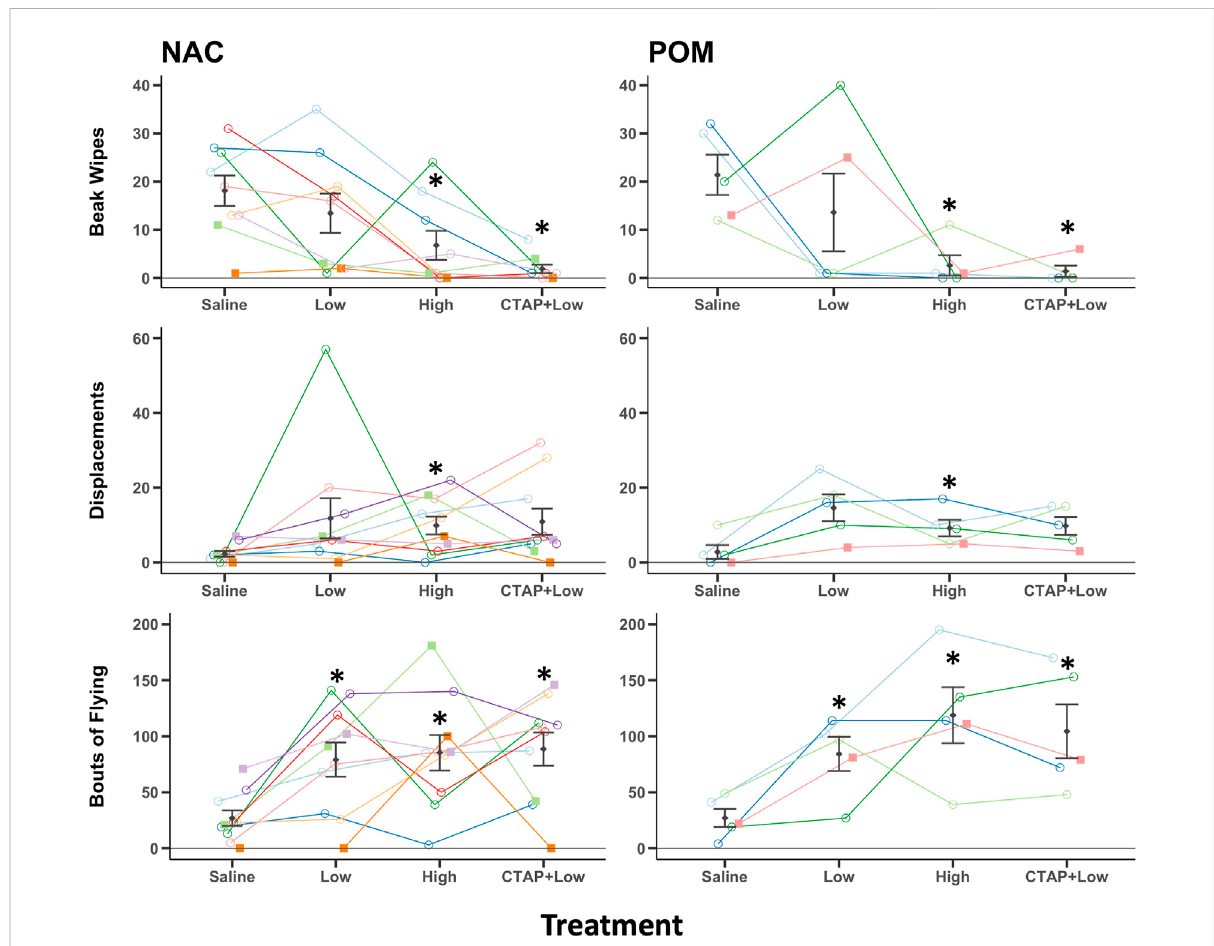
FIGURE 4 MOR stimulation in NAC or POM suppresses beak wiping but facilitates displacements and locomotion. Effects of intra NAC and intra POM treatments ofSaline, low doseDAMGO(2.5 μ g; Low),high doseDAMGO (25 μ g; High) and theMORantagonist CTAP followed bylow dose DAMGO (CTAP + Low) on beak wiping, displacements, and fl ights. Mean ± sem is indicated for each group. Individual repeated data points are shown for males (circles) and for females (squares). Site of injection was not a signi fi cant factor, but we show results for NAC and POM separately here so points for each region can be seen clearly. * indicates p < 0.05 compared to saline for NAC and POM infusions combined. See results for additional statistical